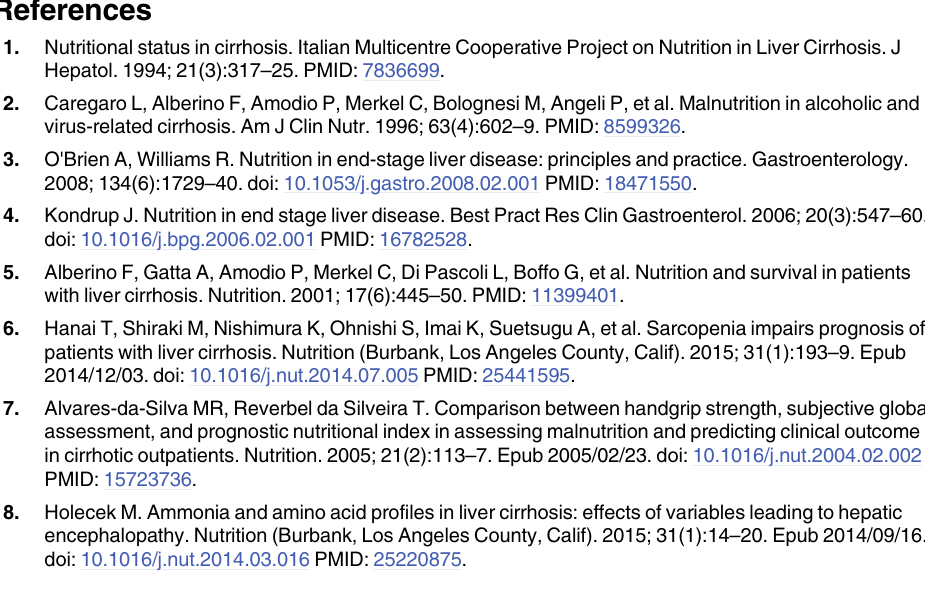
S1 Table. Hospital admission diagnoses of cirrhotic patients with and without malnutri- tion. S2 Table. Serum levels of metabolic factors, gut-derived hormones, cytokines and adipo- kines. S3 Table. Correlations between serum leptin levels, and nutritional, clinical, metabolic, and serologic factors. S4 Table. Correlations between serum leptin levels, and nutritional, clinical, metabolic, and serologic